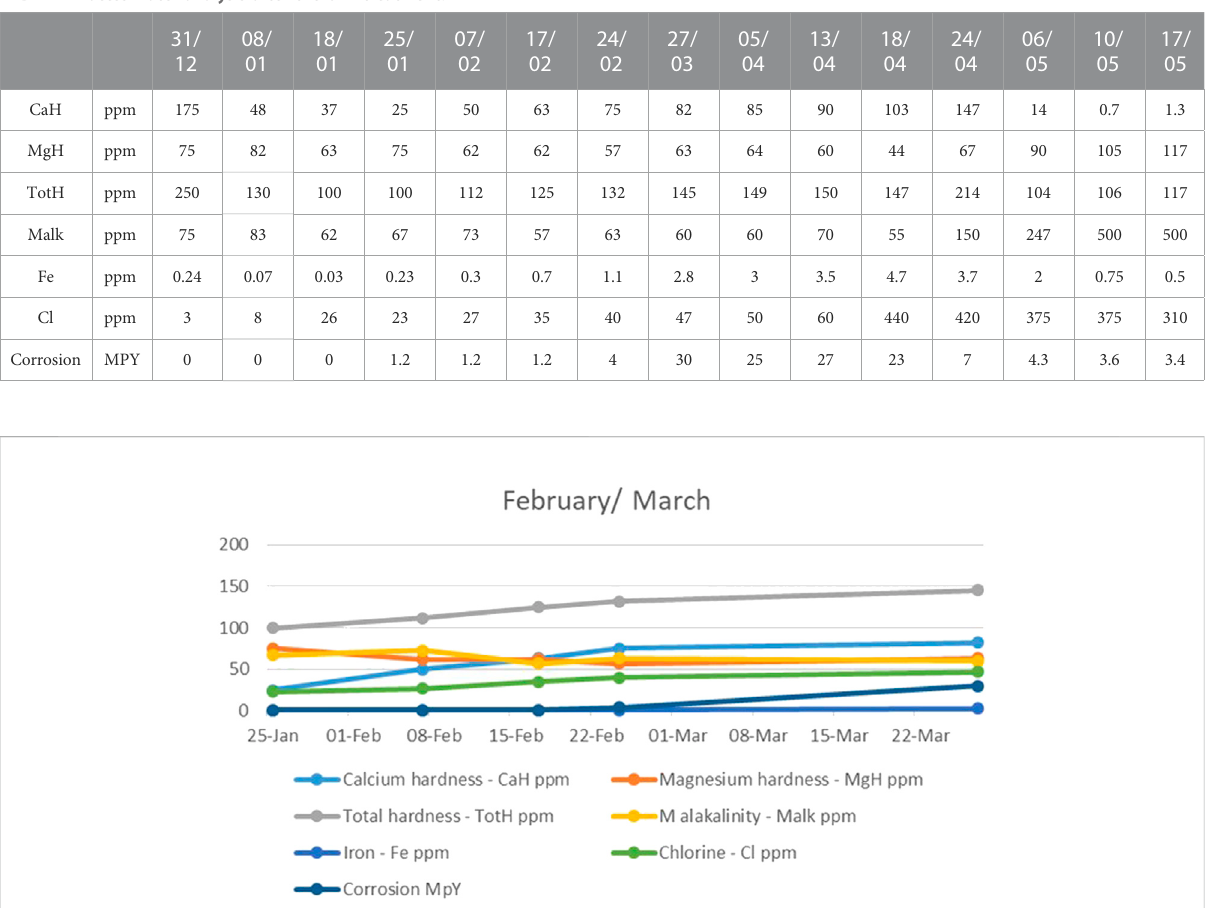
TABLE 1 Process water analysis after the UET